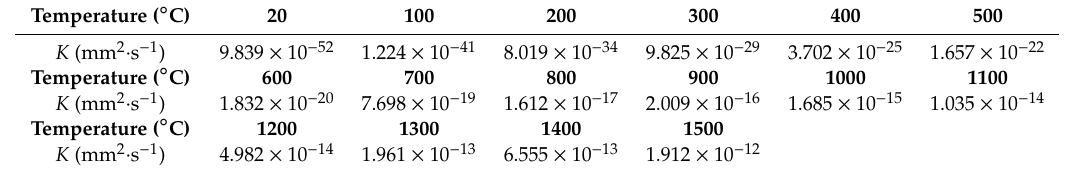
Table 4. Computed proportional constant values K defining grain growth kinetics for S700MC steel.